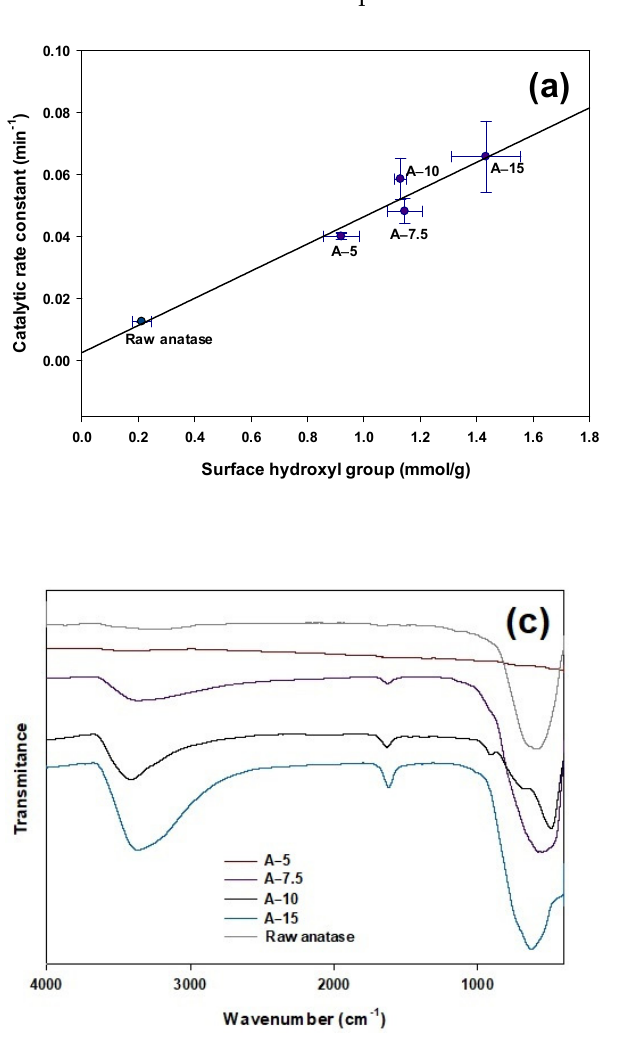
Figure 7. The linear relation between catalytic rate constant and density of surface hydroxyl groups of catalyst originating from anatase ( a ) and rutile ( b ) TiO 2 ; the FT-IR spectra of the catalyst originating from anatase ( c ) and rutile ( d ).